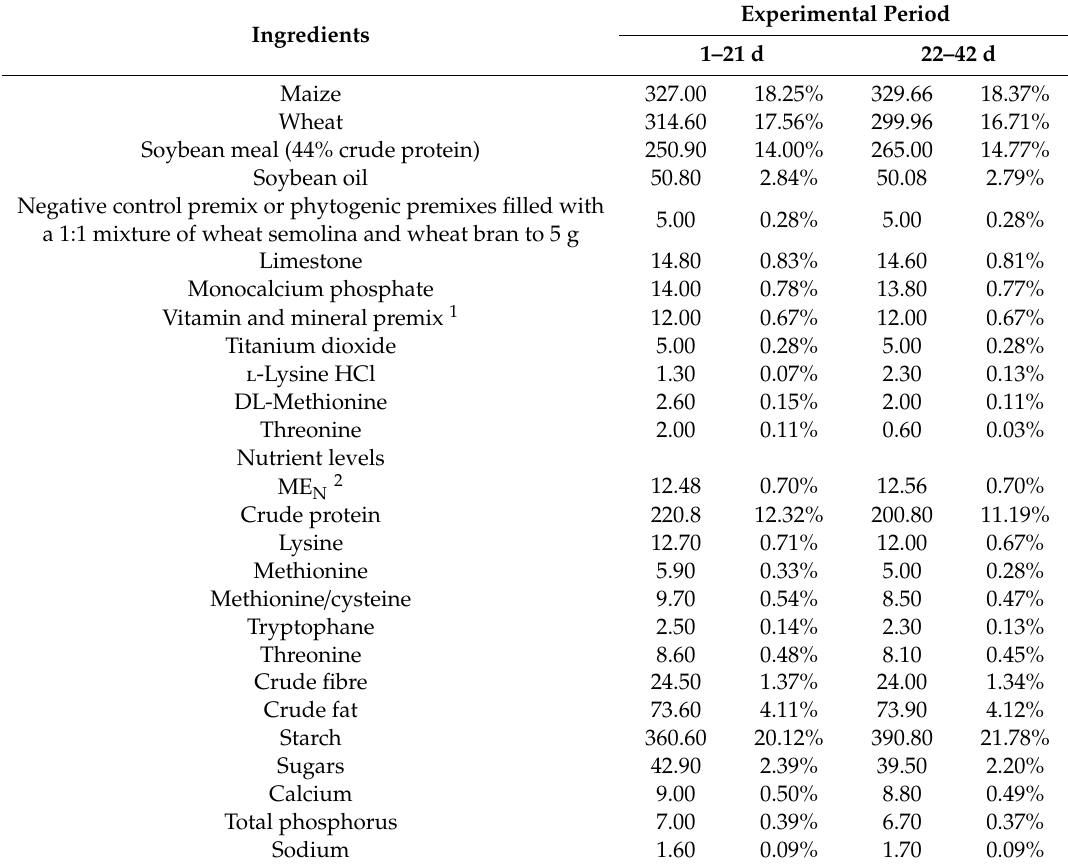
Table 4. Composition of the experimental diets (g / kg) and percentage of applied feed.